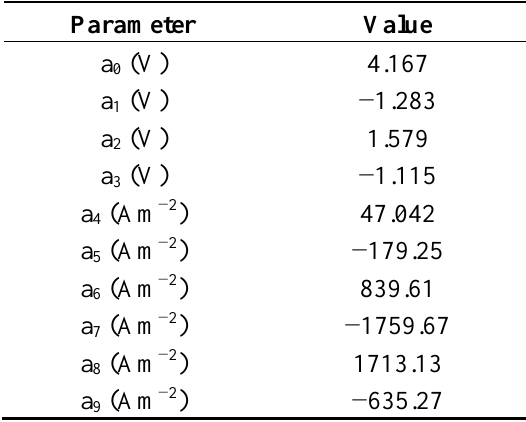
Table 1. Values of the fitting parameters a 0 –a 9 used for